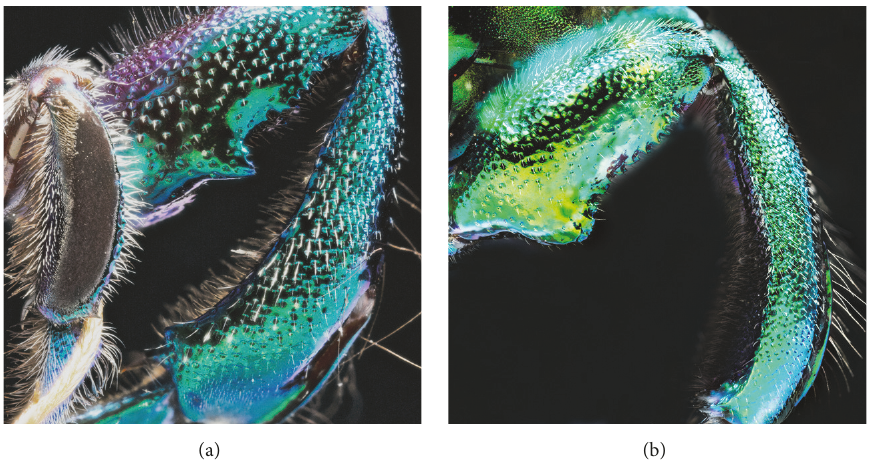
Figure 7: Male hind legs of parasitic euglossines: (a) E. dentata; (b) E. trochanterica